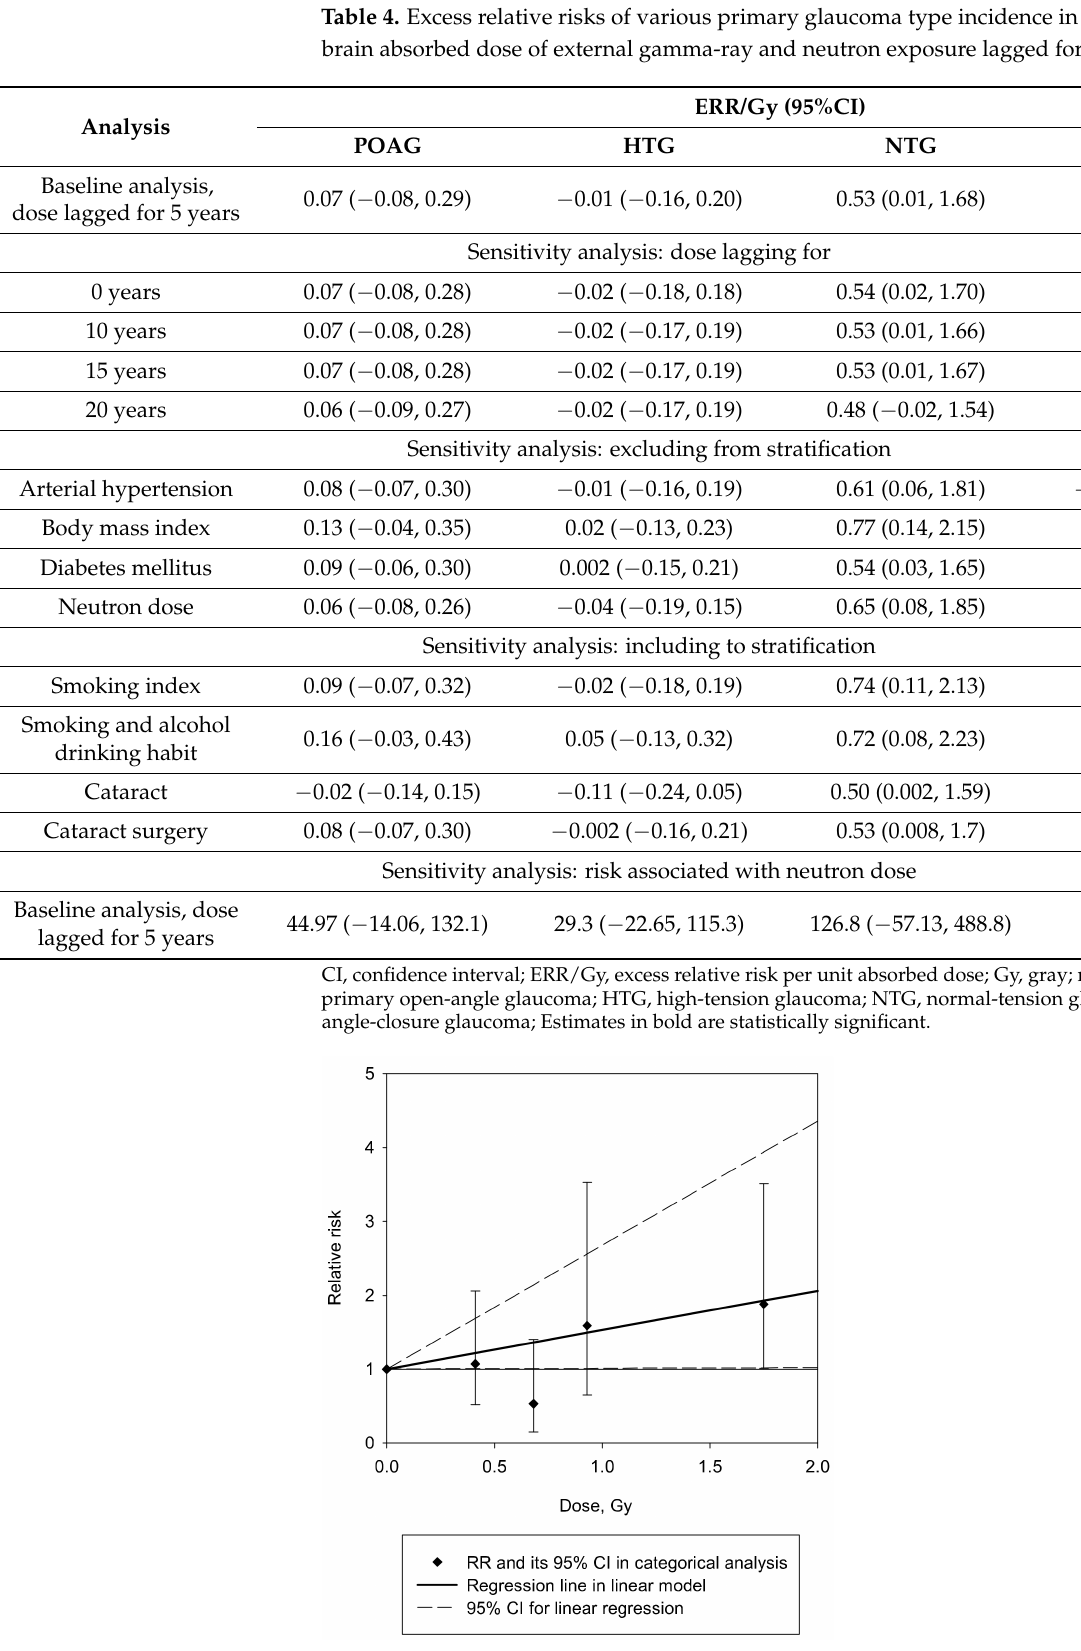
Figure 1. Normal-tension glaucoma incidence in relation to the cumulative brain absorbed gamma dose from external exposure lagged for 5